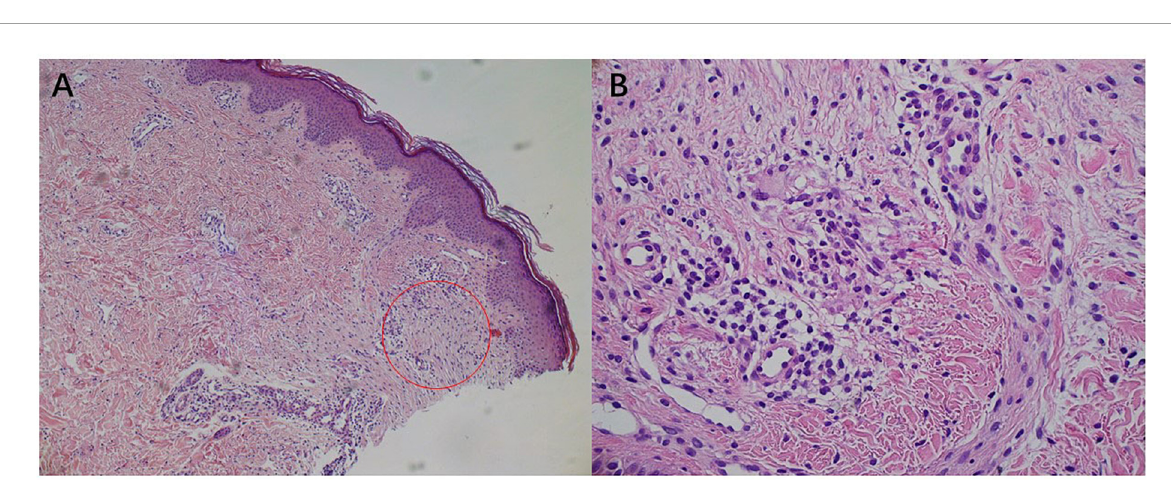
with steroids (8). Histological examination shows immature blasts infiltrate without significant dermal edema